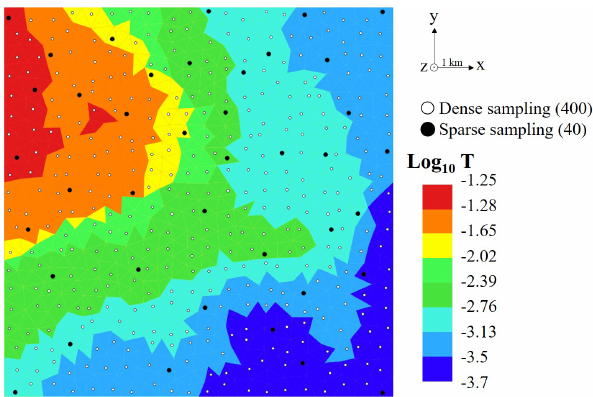
Figure 3. Transmissivity map of the aquifer and location of the wells for sparse (black dots) and dense (white dots)